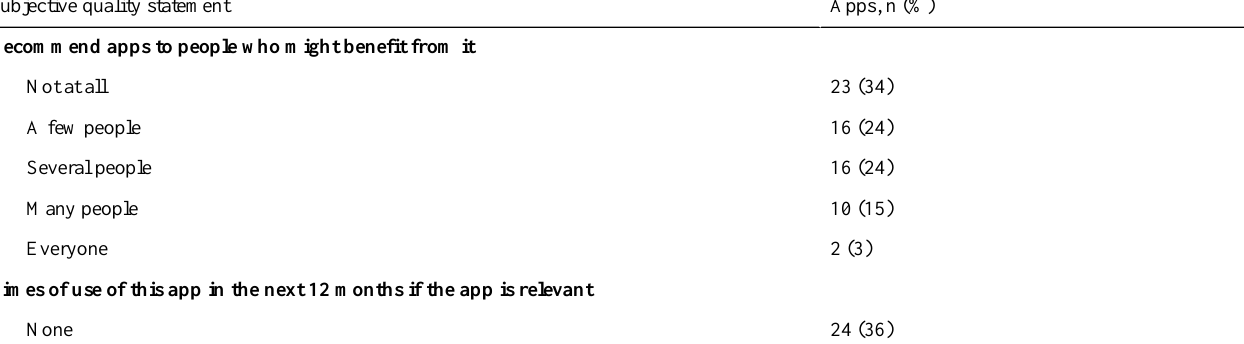
Table 1. Subjective measurement of quality of apps (N=67). Recommend apps to people who might benefit from